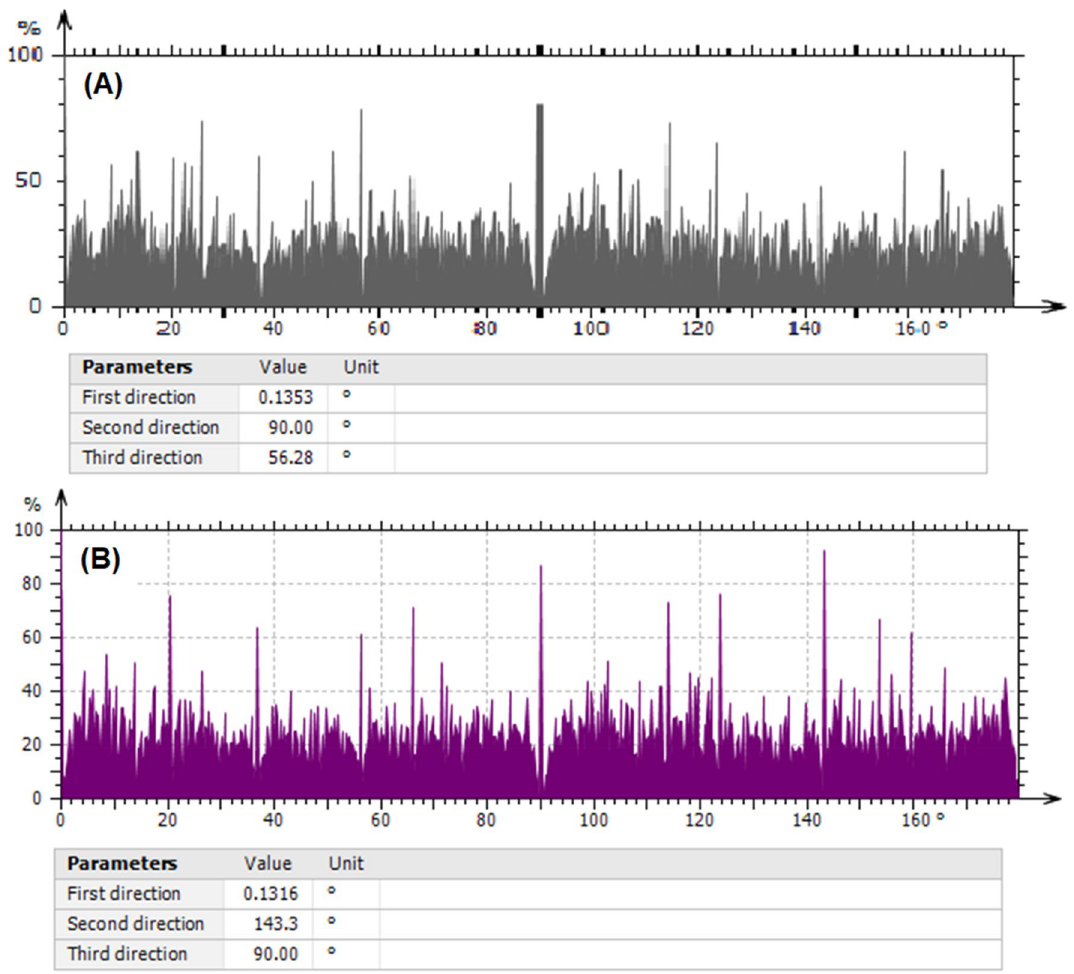
Figure 5. The representation of surface texture directions of analyzed samples using Cartesian graphs for: ( A ) before adsorption, and ( B ) after adsorption.